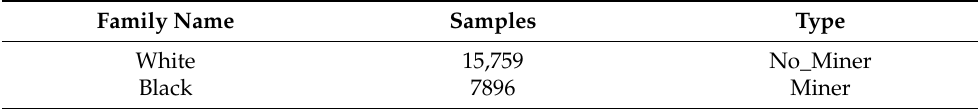
Figure 6. DataCon dataset sample distribution. Table 2. Quantity Distribution of Sample DataCon